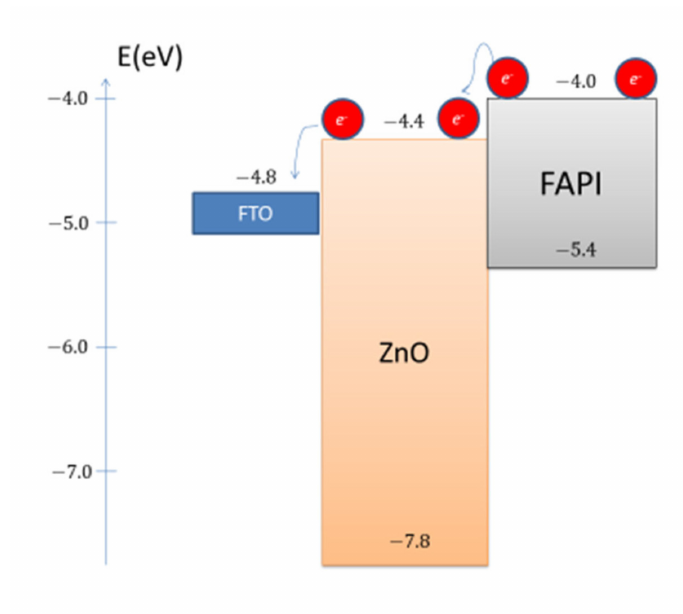
Figure 1. A scheme for energy diagram of ZnO/FAPI